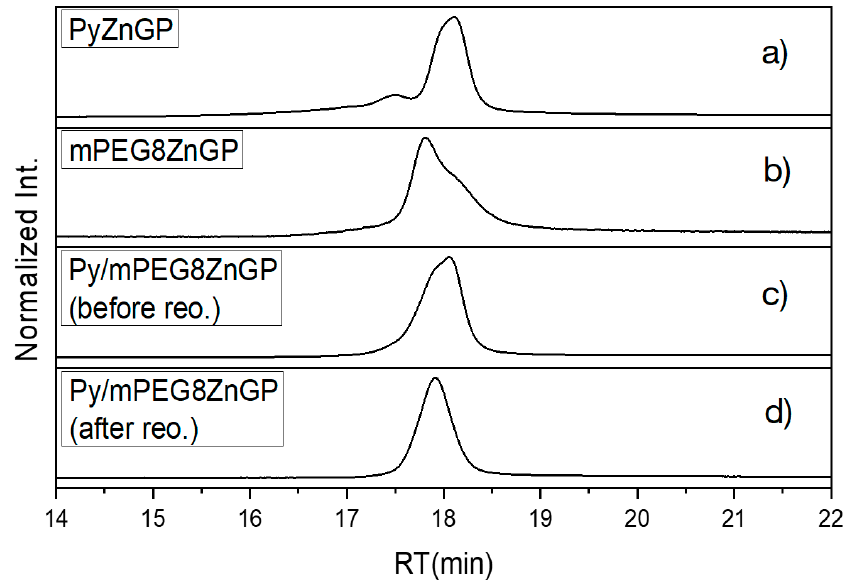
Figure 18. GPC charts of reorganized ( a ) PY-GP1 , ( b ) PEG8-GP1 , ( c ) as prepared, and ( d ) reconstituted samples of 1:1 mixture of PY-GP1 and PEG8-GP1 . (column; TOSOH TSKgel G4000H HR × 2 (exclusion limit; 400,000 Da), eluent; CHCl 3 :THF = 95:5, flow rate; 1.0 mL / min, detection; 565 nm).